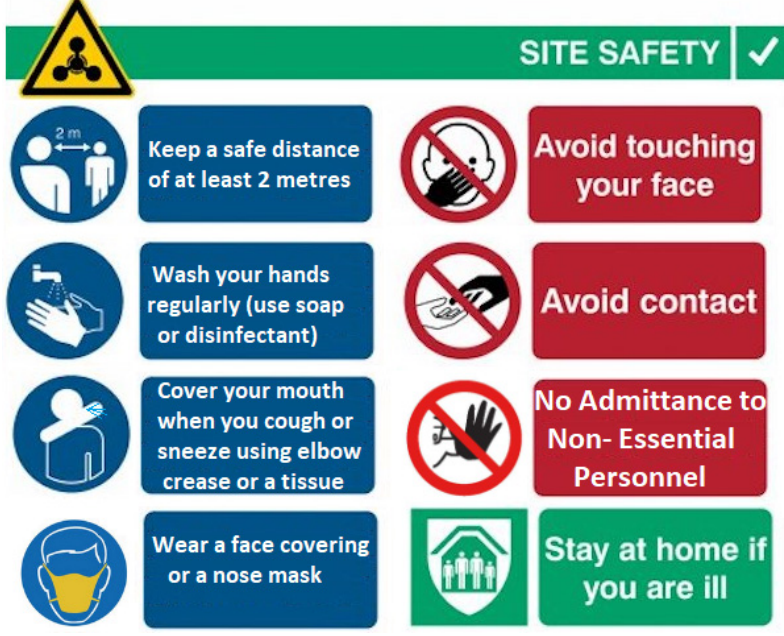
Figure 17. Typical COVID19 prevention signs for offshore facility site